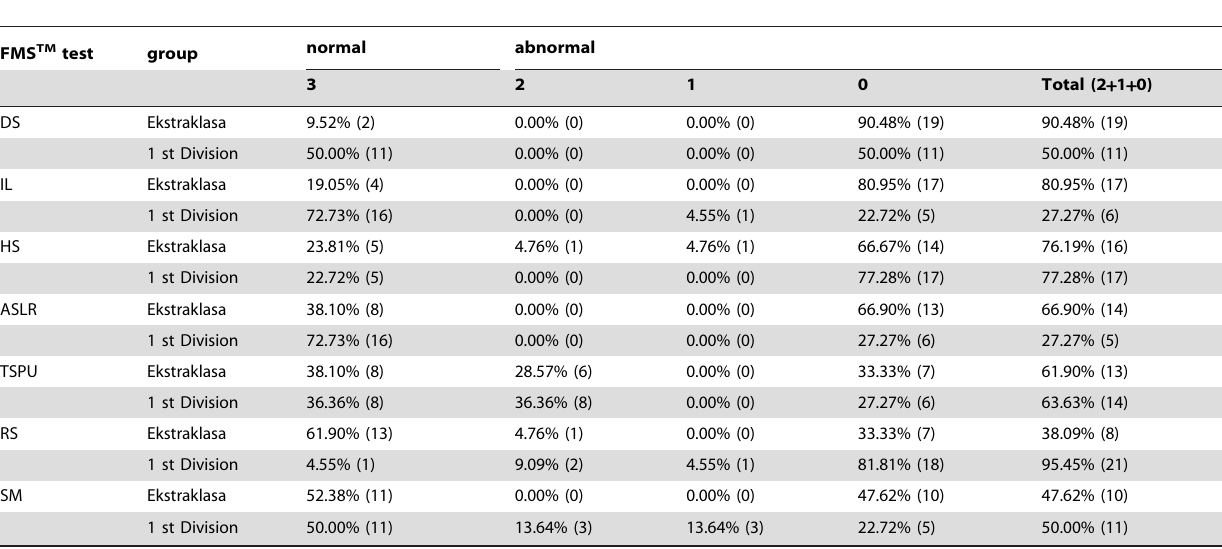
Table 4. Percentage and absolute number of players who scored the given no. of points in FMS TM tests in the two groups.